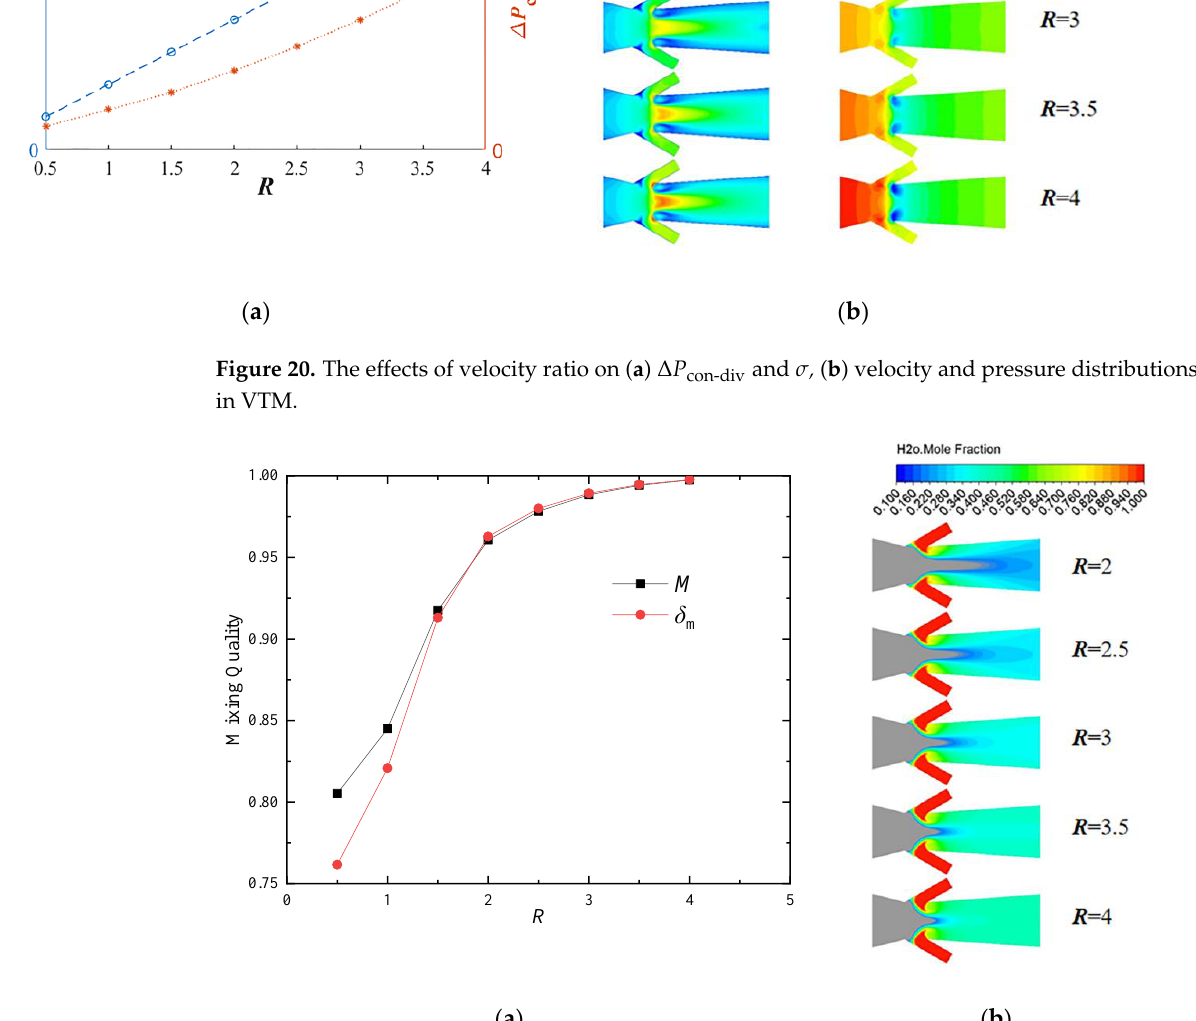
Figure 20. The effects of velocity ratio on ( a ) ∆ P con-div and σ, ( b ) velocity and pressure distributions in VTM.